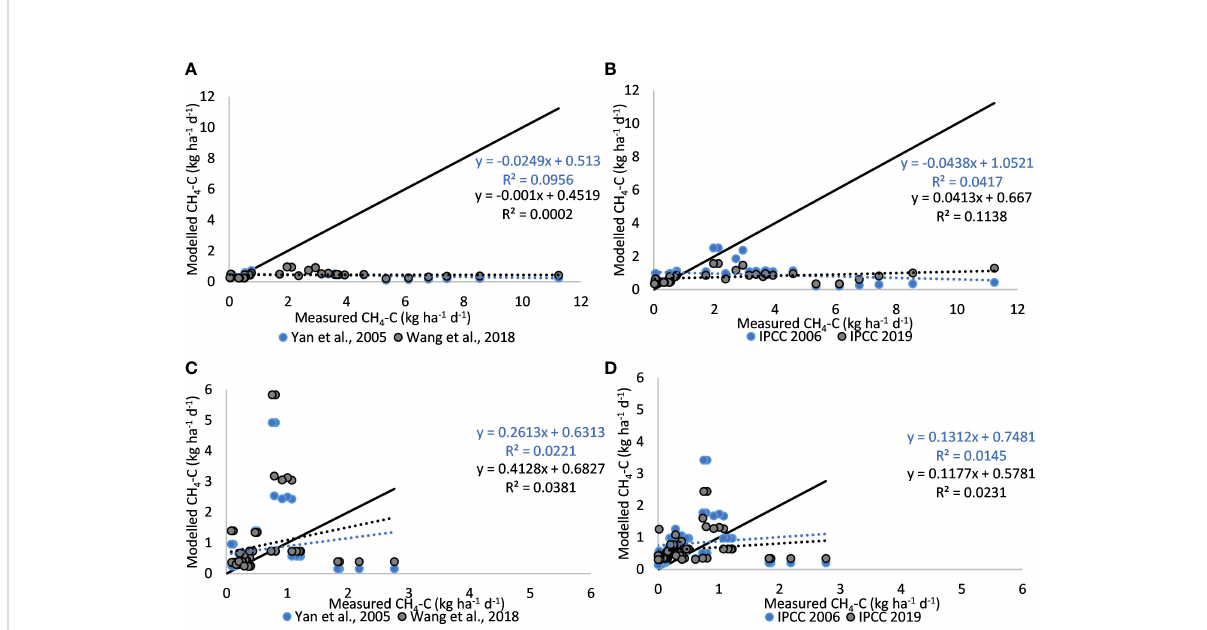
FIGURE 5 Modelled and observed CH 4 emission for Bangladesh (A, B) and India (C, D) with Yan and Wang tier 3 models in a and c and IPCC tier 1 models in b and d (solid line indicates 1:1). Sample size n = 35 for Bangladesh and India, n = 82 for tier 1 models and 68 for tier 3 models.